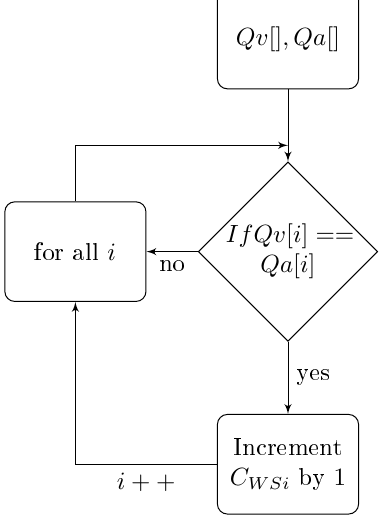
Figure 3. Flowchart for Credibility